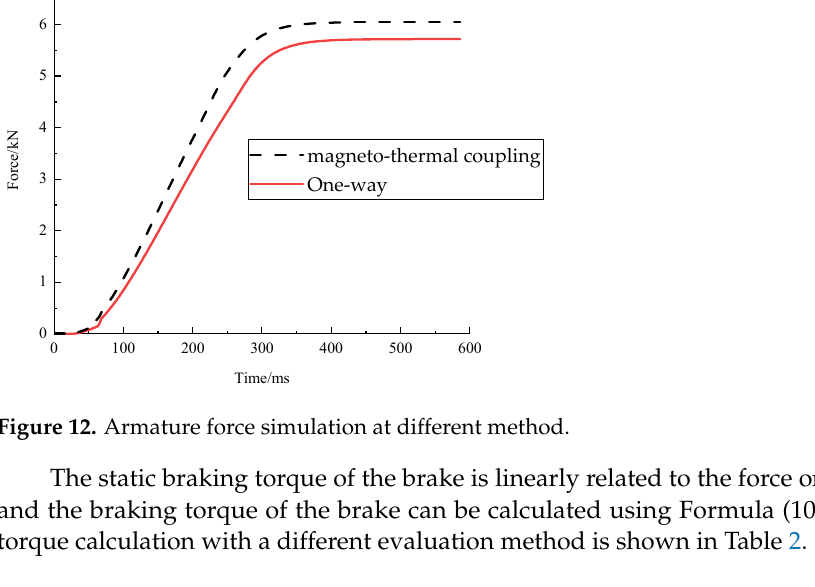
Figure 11. Transient analysis of permanent magnet brake at 105 °C .